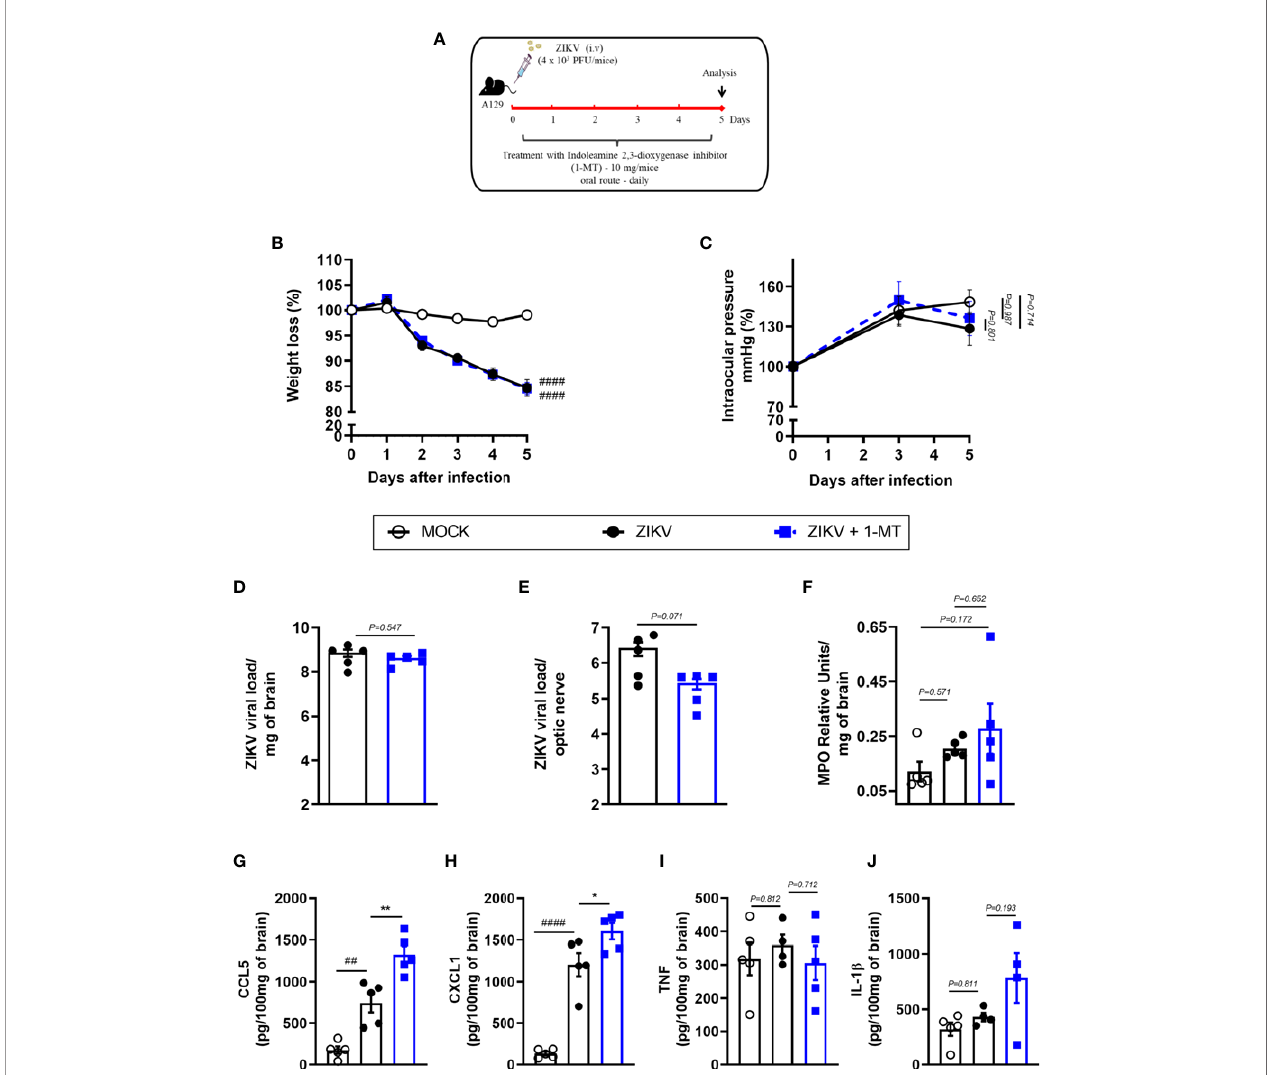
FIGURE 3 | Clinical signs and in fl ammatory parameters in A129 mice infected by ZIKV treated or not with 1-MT inhibitor. (A) Experimental schematic representation of experimental strategy. A129 were inoculated (i.v) with 4x10 3 PFU/200 m L of ZIKV and treated daily with 1-MT. (B) The body weight was evaluated daily and (C) the intraocular pressure was analyzed on days 0, 3 and 5. At day 5 of infection, (D) the brain and (E) optical nerve was harvested for plaque assay analysis. (F) Measurement of myeloperoxidase activity (neutrophil accumulation) and (G – J) chemokine/cytokine production was assessed in mouse brain of animals. All results are expressed as mean and error bar indicate the standard error (SEM) and are representative of at least two independent experiments. Statistically signi fi cant differences were assessed by Two-way ANOVA plus Tukey ’ s comparisons test (A, B) , Mann Whitney test (D, E) and One-way ANOVA (F – J) plus Tukey ’ s comparisons test. (##) for P < 0,01 and (####) for P < 0,0001 when compared to the MOCK group. (*) for P < 0,05 and (**) for P < 0,001 compared to the ZIKV